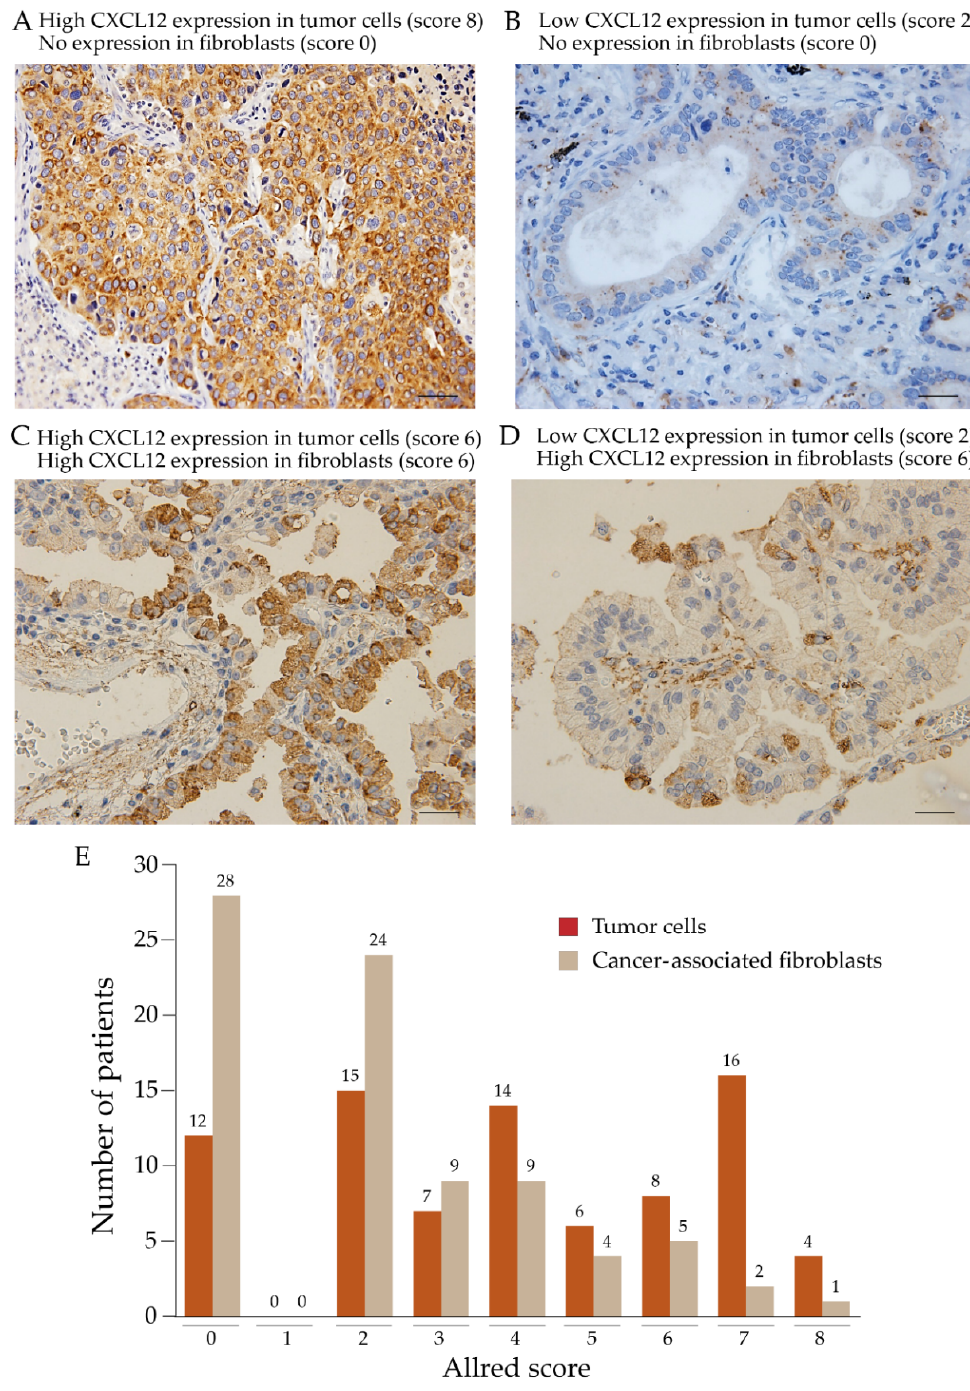
Figure 2. Expression of CXCL12 in tumor tissue from non-small cell lung carcinoma patients. The expression of CXCL12 was evaluated as described under material and methods. ( A ) Tumor with high expression of CXCL12 in tumor cells with no expression in cancer-associated fibroblasts. ( B ) Tumor with low expression of CXCL12 in tumor cells with no expression in fibroblasts. ( C ) Tumor with high expression of CXCL12 in tumor cells and cancer-associated fibroblasts. ( D ) Tumor with low expression of CXCL12 in tumor cells and increased expression in fibroblasts. ( E ) The number of patients in each Allred score. Scale bars indicate 50 µm (400 × magnification). Overall, 85.3% (70/82) of tumor cells and 65.9% (54/82) of cancer-associated fibroblasts were positive for CXCL12.